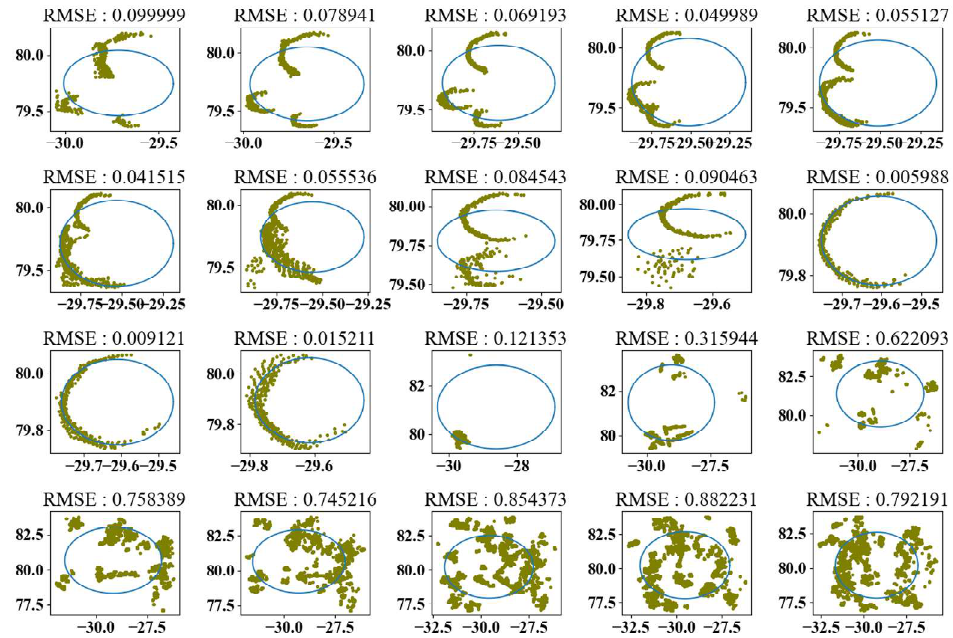
Figure 4. The fitting results and RMSE of slices.